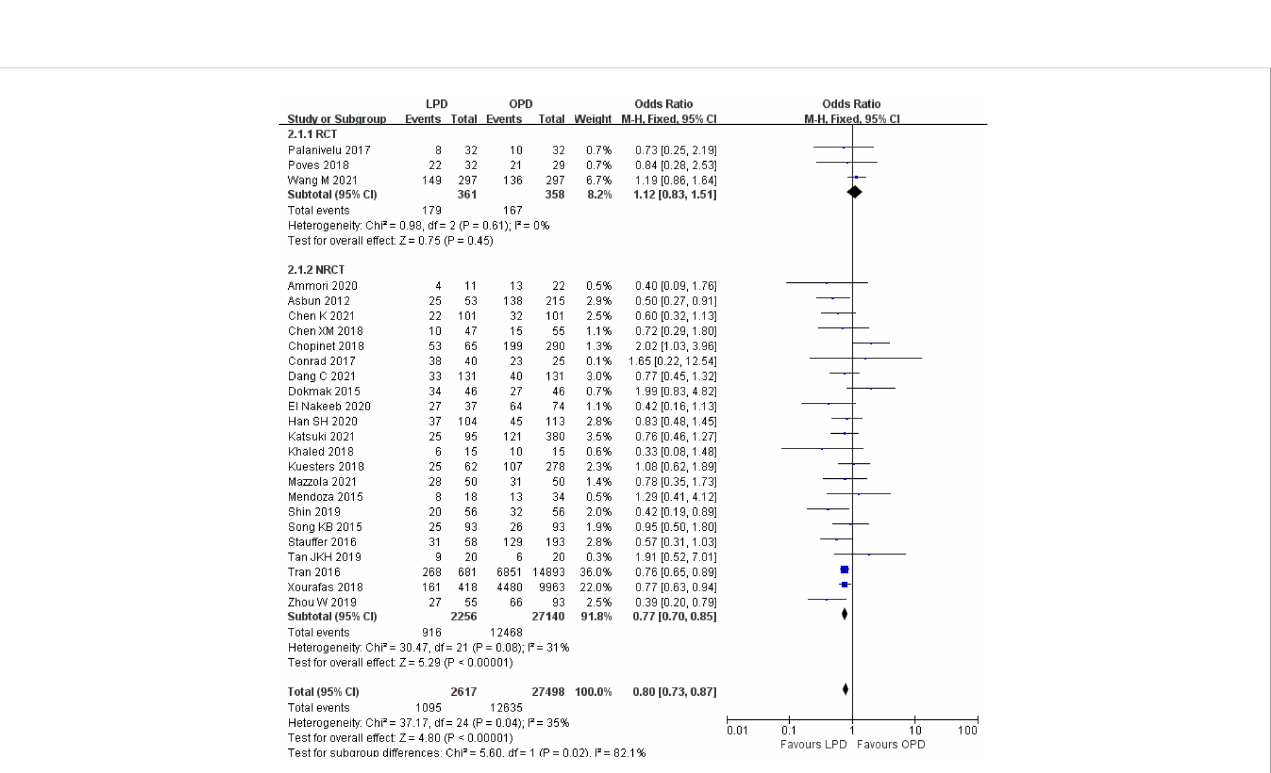
FIGURE 2 Forest plot of comparison between LPD and OPD on overall postoperative complications. LPD, laparoscopic pancreaticoduodenectom; OPD, open